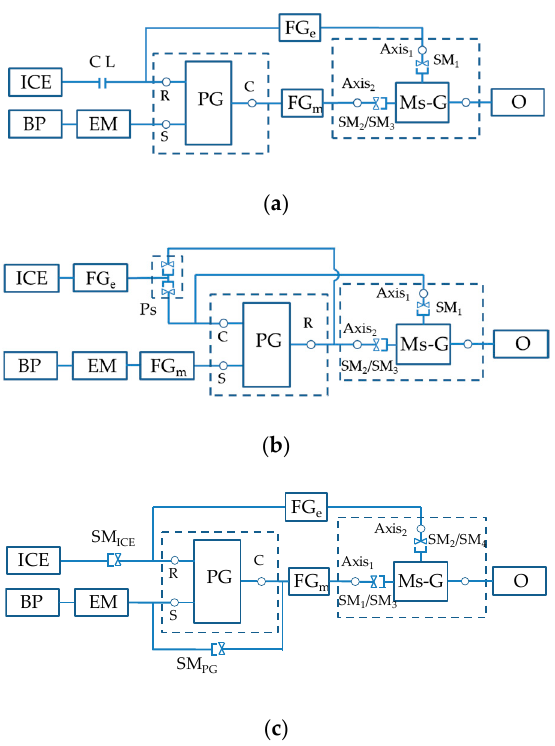
Figure 15. Type-d SEM PHPS architecture: ( a ) hybrid drive train (HDT); ( b ) Hitachi active shift transmission (HAST); ( c ) clutchless geared smart transmission (CGST). (Ms-G—multi-axis gearbox; FG—fixed gear; SM—synchromeshes; Ps—path switch; CL—clutch.). Table 3. Comparison of the three hybrid transmission systems and the dal clutch (DCT) system.